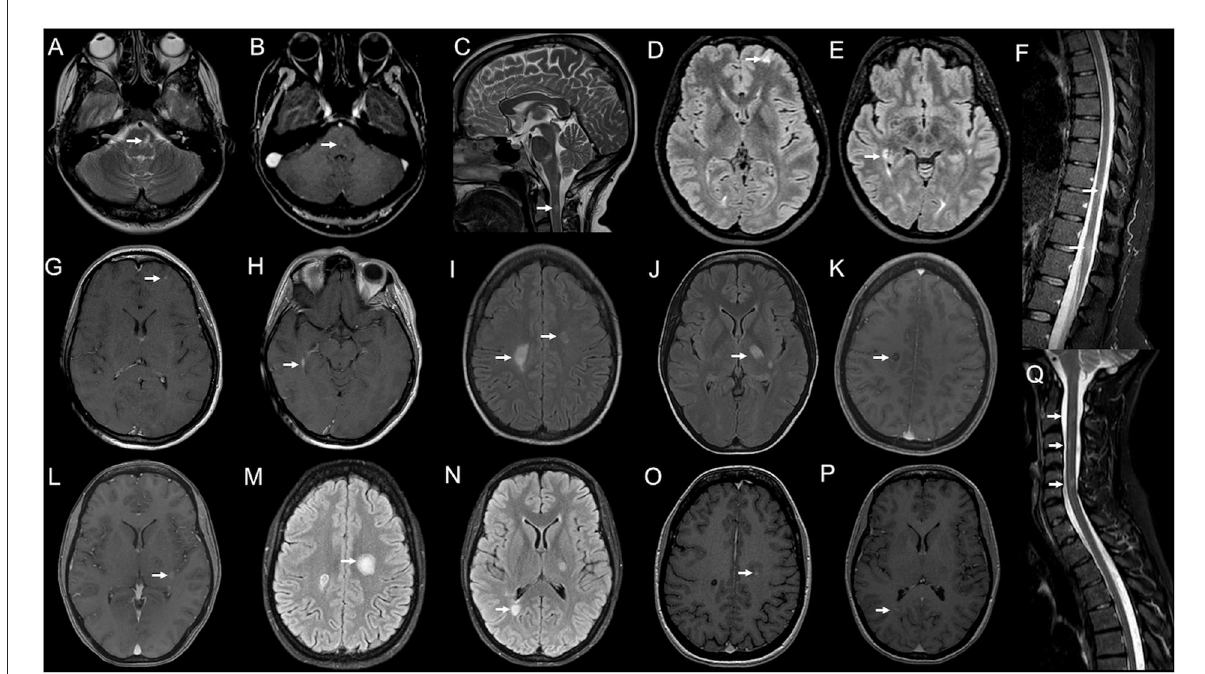
FIGURE2 Serial brain and spinal cord MRI scans in Case 3 (A–H ) and Case 4 (I–Q) . Case 3: (A) Brain MRI performed 25 days after BNT162b2 second dose, showing a T2-weighted hyperintensity (arrow) in the left paramedian mid-pons with blurred enhancement on T1-weighted images [ (B) ; arrow] and a non-enhancing spinal lesion at C2–C3 level [ (C) ; arrow]. (D–H) 2-months MRI follow-up showing two new brain lesions—one juxtacortical in the left frontal hemisphere [ (D) ; arrow] and one periventricular abutting the right lateral ventricle occipital horn [ (E) ; arrow], both with contrast-enhancement [ (G,H) ; arrows] and two spinal lesions at the dorsal level [ (F) ; arrows], with no contrast enhancement (not shown). Case 4: (J–L) Brain MRI obtained 10 days after BNT162b2 second dose, revealing T2-weighted hyperintensities in both centra semiovale (CSO) [ (I) ; arrows] and left thalamus/posterior limb of the internal capsule (IC) [ (J) ; arrow]; lesions in the right CSO [ (K) ; arrow] and left IC [ (L) ; arrow] showed blurred contrast enhancement on T1-weighted images. (M–P) 20-days MRI control showing the enlargement of the left CSO lesion [ (M) ; arrow] and a new lesion in the right peritrigonal area [ (N) , arrow], both with gadolinium-enhancement on T1-weighted images [ (O,P) ; arrows]. (Q) Spinal cord MRI—obtained 10 days after the brain exam—showing three blurred areas at C2, C3, and C5–C6 levels on STIR sequences, with no enhancement (not